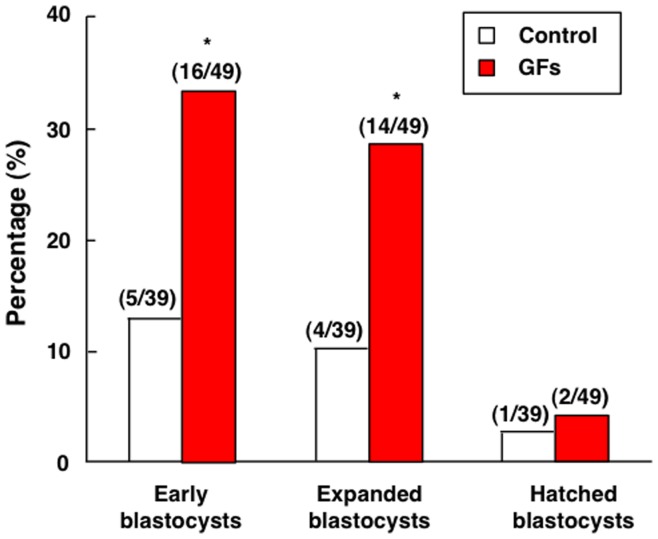
Effects of growth factor treatment on the development of cultured tri-pronuclear zygotes.Human tri-pronuclear zygotes were cultured individually in micro-drops containing serum-free media with or without key growth factors for up to 144 h. Morphological changes were monitored for blastocyst formation at early, expanded, and hatched stages. Numbers of embryos developed to specific stages vs. total number of embryos studied are listed on top of each column. *, P<0.05 vs. control. GFs: growth factors.